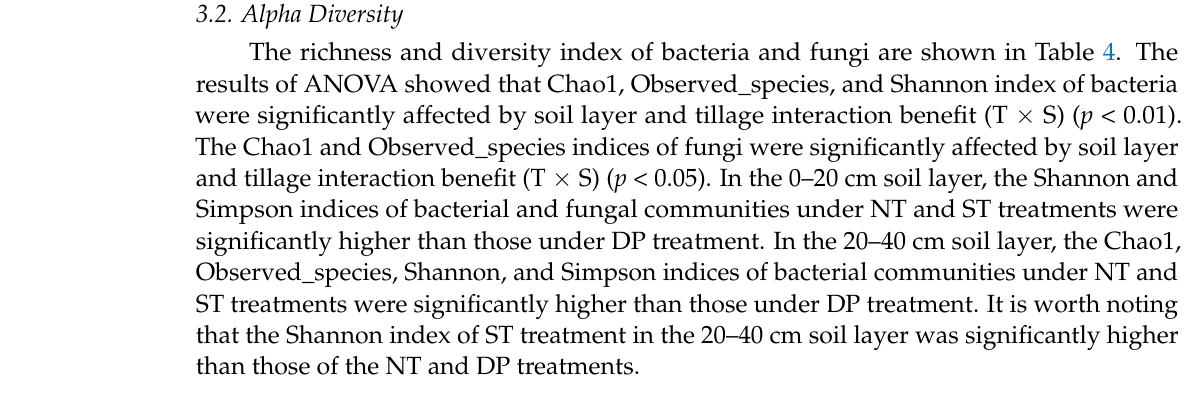
Table 4. Effects of tillage methods on the Alpha diversity index of soil bacteria in the 0–40 cm soil